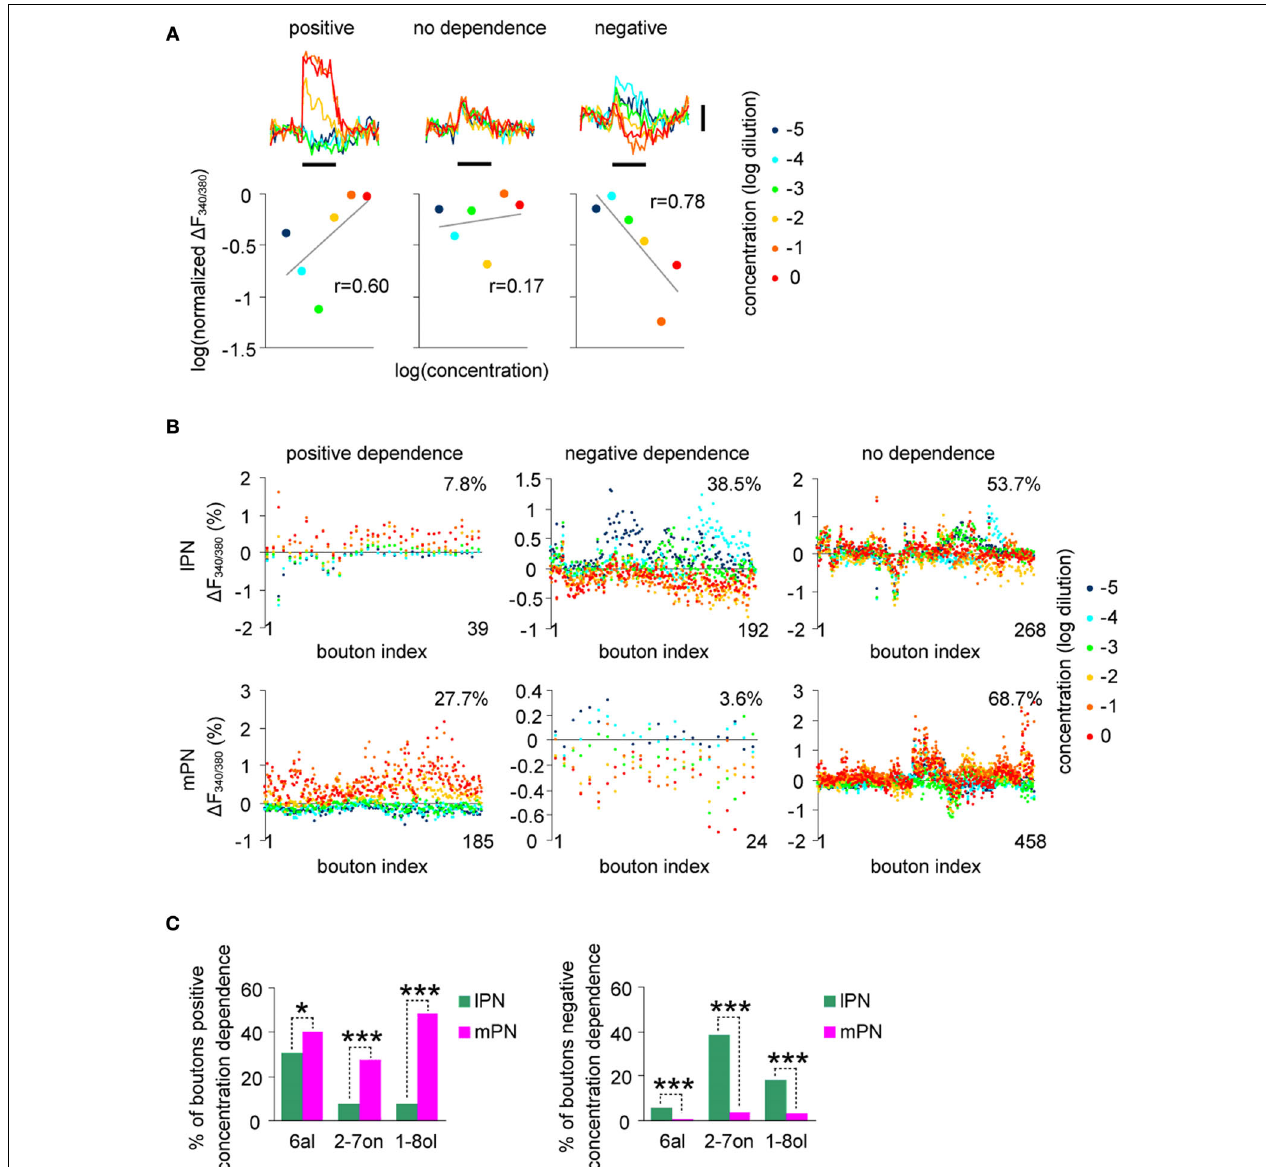
FIGURE 4 | lPN and mPN boutons differ in their concentration dependence. More boutons in lPN fell into the group of negative concentration dependence. (A) Boutons were categorized into three groups (positive, no dependence, More boutons in mPN fell into the group of positive concentration dependence. negative) by their correlation between the logarithm of normalized response (C) More mPN boutons (magenta) exhibited positive dependence (left) and more strengths and odor concentrations. Black bars under the traces indicate the odor lPN boutons (green) exhibit negative concentration dependence (right) for all stimulus for 3 s. Vertical scale bar: 1% in Δ F . (B) Categorized boutons and three odors, all of which are signifi cantly different (*, p < 0.05, ***, p < 0.001, 340/380 their response strengths in the 2-heptanon (2-7on) concentration series. chi-square test). The following numbers of boutons were included for the Boutons were categorized according to three criteria in (A) . All boutons are analyses: lPN: 6al, 540 boutons, experiments from 7 bees, 2-7on, 499 boutons, horizontally aligned in each fi gure (bouton index), in which response strengths of 8 bees, 1-8ol, 538 boutons, 7 bees; mPN, 6al, 274 boutons, 4 bees, 2-7on, 667 each bouton for different concentrations are vertically aligned by different colors. boutons, 8 bees, 1-8ol, 282 boutons, 5